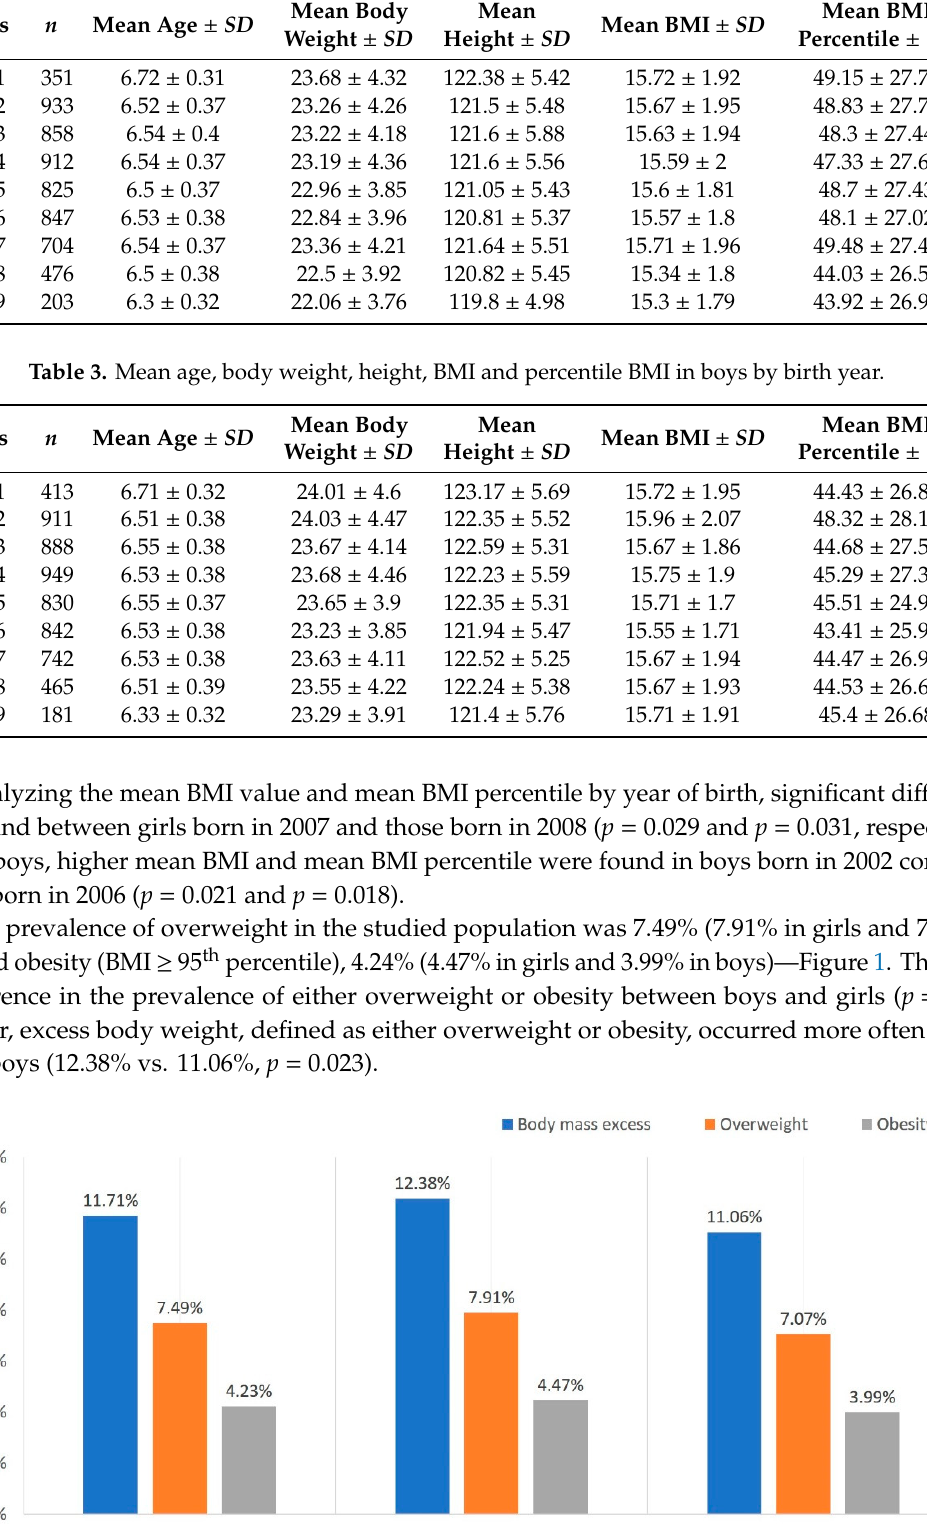
Table 2. Mean age, body weight, height, BMI and percentile BMI in girls by birth year. Girls n